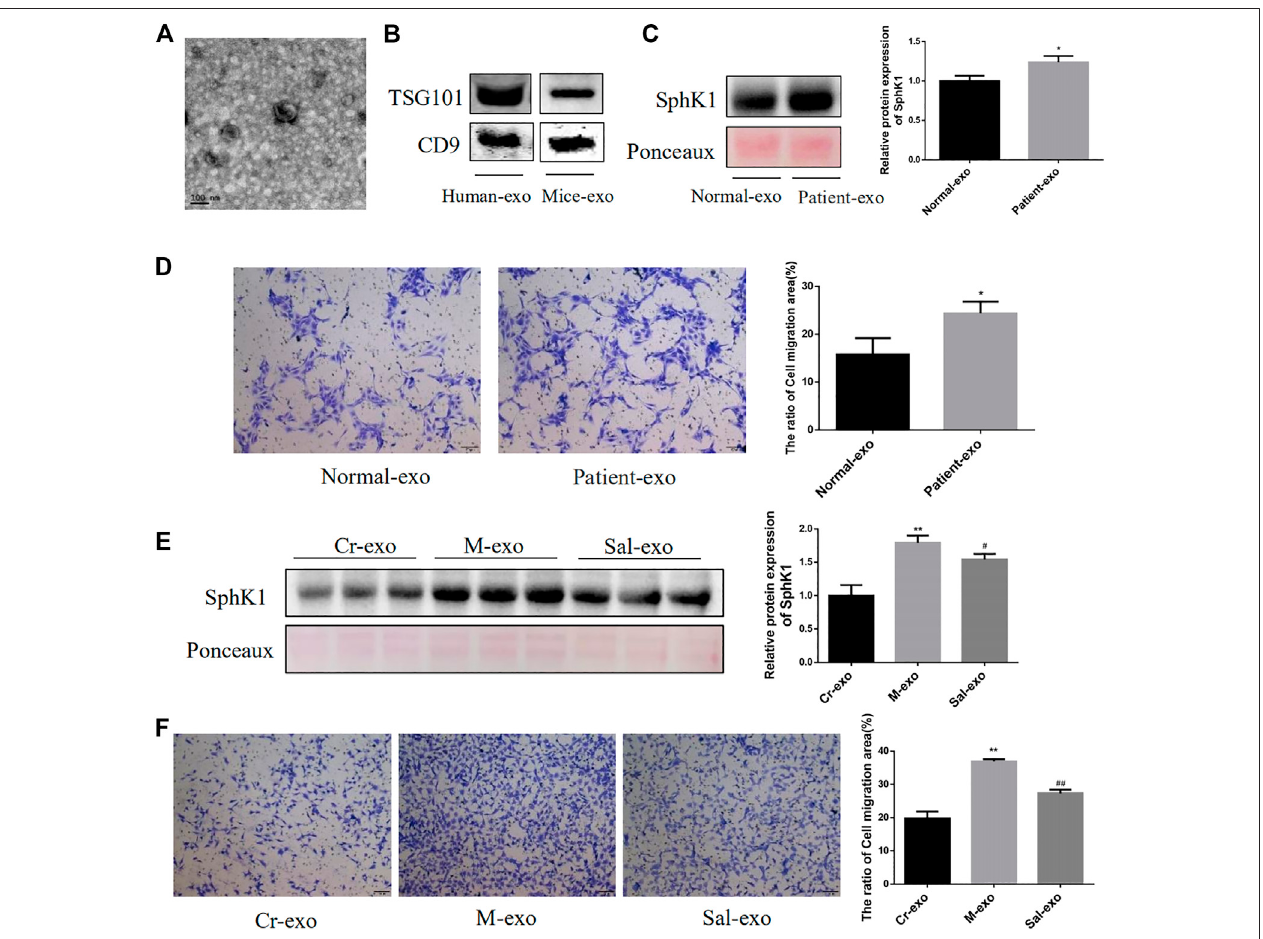
FIGURE 4 | Characteristics of serum exosomes and their effect on migration of HSC. (A) : Serum exosomes had a double-layer membrane structure. (B) : ExpressionofTSG101andCD9inserumexosomesfromhumanandmice. (C) :ExpressionofSphK1inserumexosomesfromhuman( n (cid:1) 6,* p < 0.05,vs.Normal-exo.) (D) : Effects of serum exosomes from different populations on LX-2 migration ( n (cid:1) 6, * p < 0.05, vs Normal-exo.) (E) : Expression of SphK1 in serum exosomes from differentgroupsofmice( n (cid:1) 15,** p < 0.01,vs.Cr-exo, # p < 0.05,vs.M-exo,) (F) :EffectsofserumexosomesfromdifferentgroupsofmiceonJS1migration( n (cid:1) 15, ** p < 0.01, vs Cr-exo, ## p < 0.01, vs. M-exo.) TSG101: tumor susceptibility gene